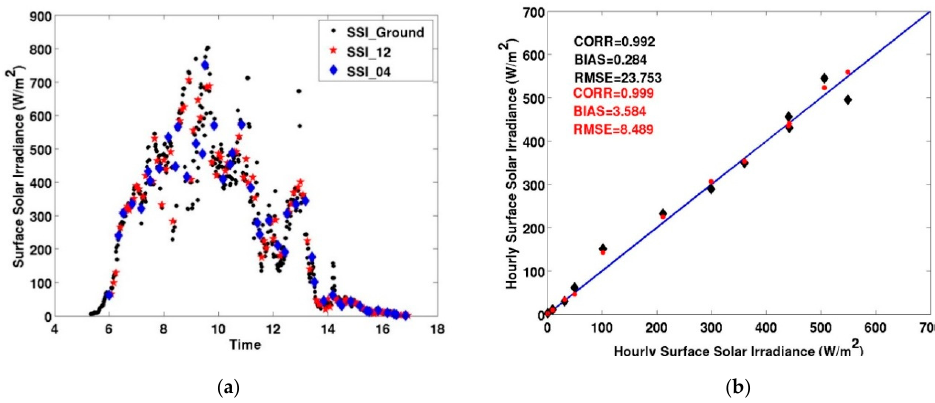
Figure 4. Data from 17 March 2018 at the Institute of Methodologies for Environmental Analysis of